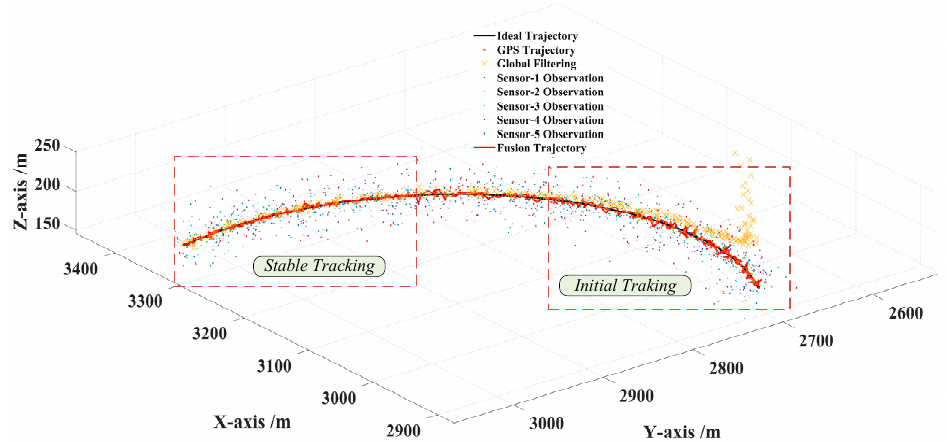
Figure 11. Three-dimensional schematic diagram of tracking results by five sensors.